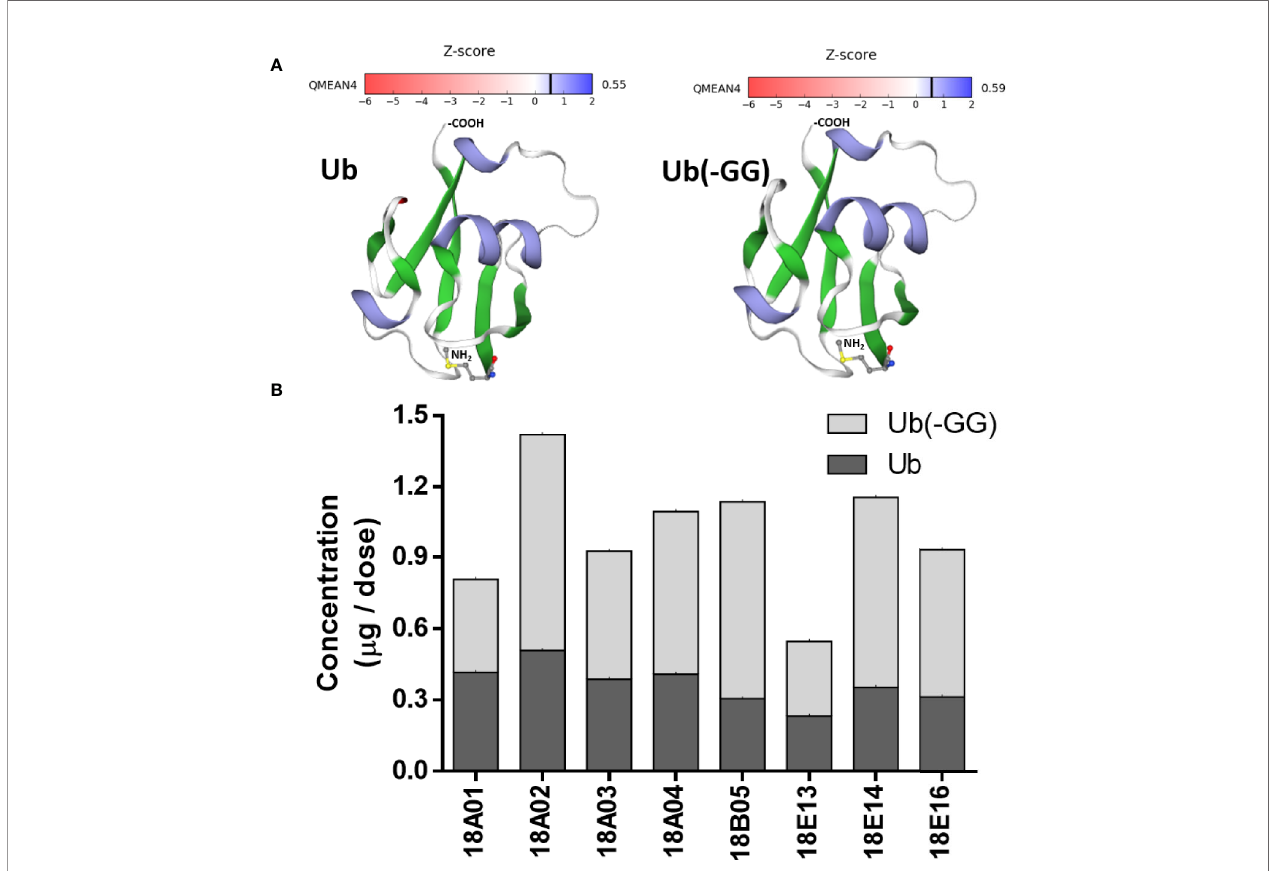
FIGURE 8 | Structural comparison of Ub and Ub(-GG) and total Ub quantitation in Transferon. (A) It was evaluated the impact of the lack of the terminal Gly on the structure of Ub using the SWISS-MODEL homology-modeling tool. Ub and Ub(-GG) were considered the same as they have similar shapes and Z-scores. (B) In this sense, the total Ub content of eight Transferon batches was quantitated per dose (5 mL) using the intact mass method. The average concentrations were 0.366 m g/ dose (CV, 22.97%), 0.637 m g/dose (CV, 33.46%), and 1.003 m g/dose for monomeric Ub, Ub(-GG) and total Ub, respectively.